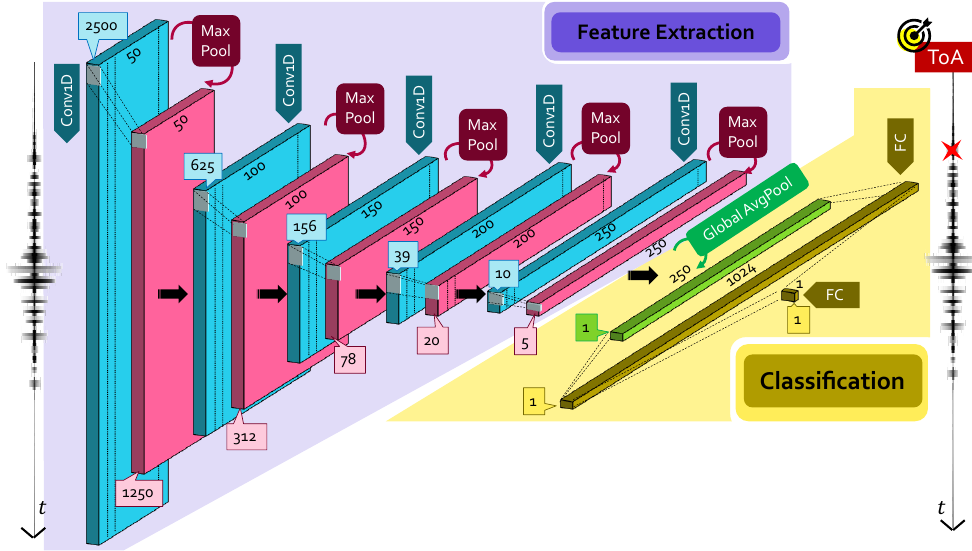
Figure 2. Proposed CNN for ToA estimation in 5000-long time series. The quantities reported in the blue and pink boxes indicate the dimensions of the output features of the corresponding